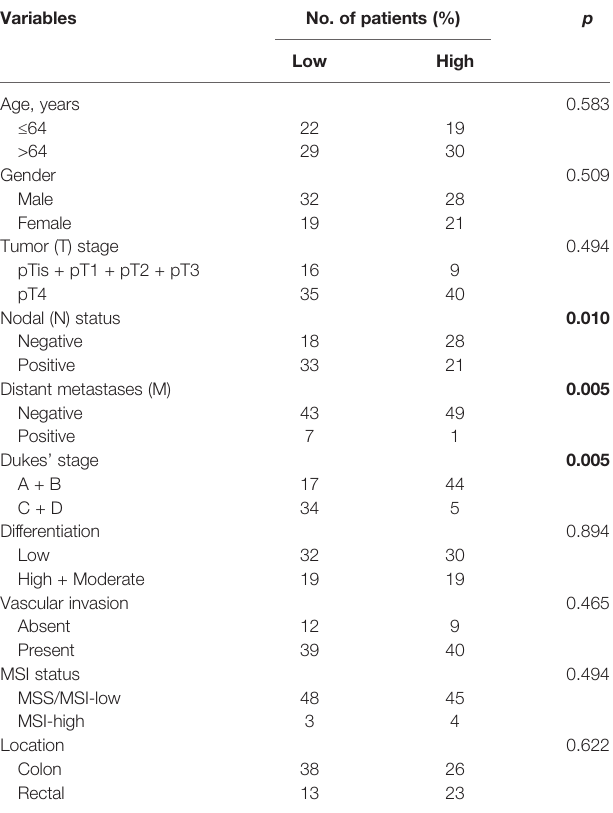
The bold face indicates p-values of variables with signi fi cance in either univariate or multivariate